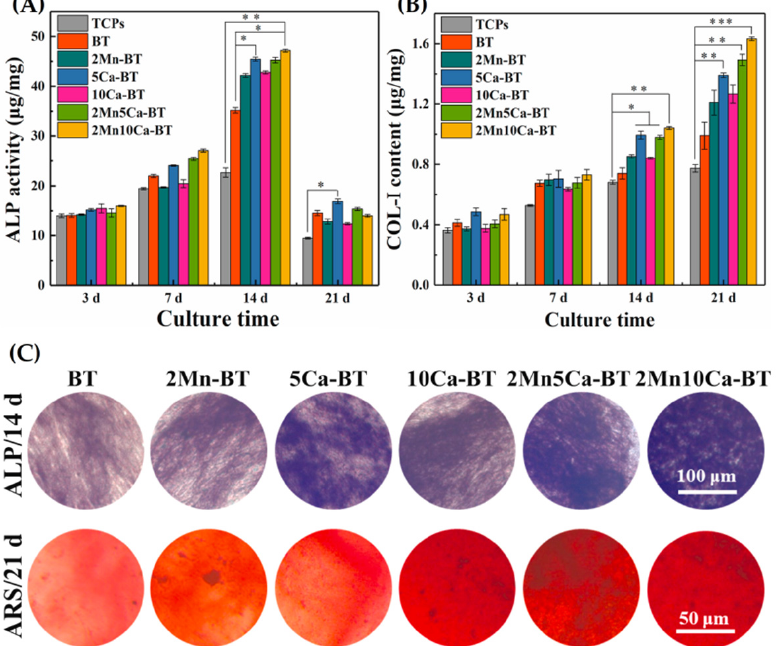
Figure 12. Evaluation of osteogenic differentiation of BMSCs cultured on doped and non-ion doped nanofibers compositions by an analysis of osteogenesis-related markers including: ( A ) quantitative analysis on ALP activity; ( B ) quantitative analysis on COL-I synthesis; ( C ) ALP staining and Alizarin red staining for calcium modules. * p < 0.05, significant; ** p < 0.01 and *** p < 0.001, highly significant ( n = 4). Reprinted from [197], copyright (2021), with permission from Ceramics Interna- tional.